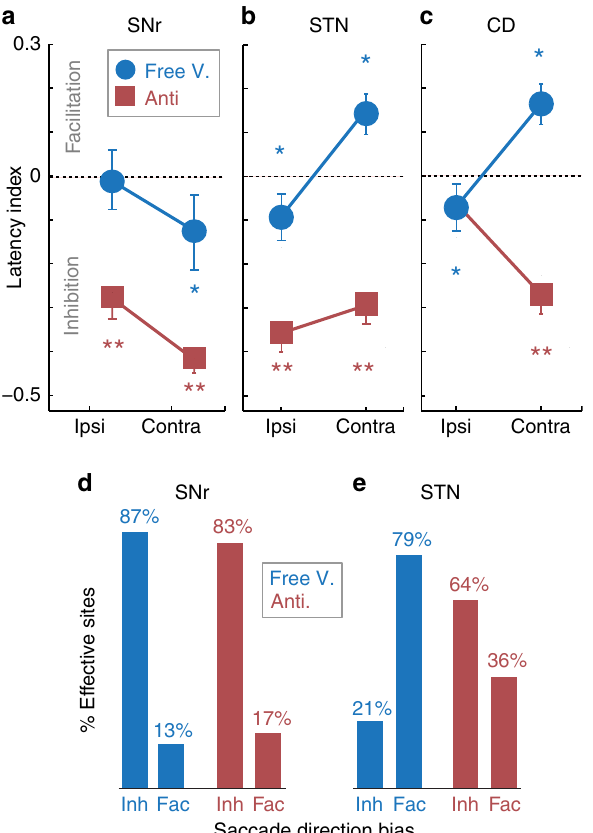
Fig. 5 Summary of effects. a – c SNr, STN, and caudate nucleus stimulation effects on saccade latency during free viewing (blue) and anti-saccade (red) conditions. Caudate nucleus and STN stimulation resulted in task- speci fi c saccade direction biases while the SNr did not; caudate and STN direction biases were opposite to SNr direction biases during free viewing saccades (i.e., contraversive facilitation versus inhibition), but comparable to the SNr during goal-driven anti-saccades (i.e., bilateral inhibition). Error bars indicate standard error. d , e A summary of % sites with a signi fi cant difference in saccade frequency after stimulation (paired t- test, p < 0.05) supports task-speci fi c effects of the STN. Inhibition (inh) describes any site with either an ipsiversive saccade bias (de fi ned by an increased frequency of ipsiversive saccades, or a greater decrease in contraversive than ipsiversive saccade frequency), or a bilateral decrease in saccade frequency. Facilitation (fac) describes any site with either a